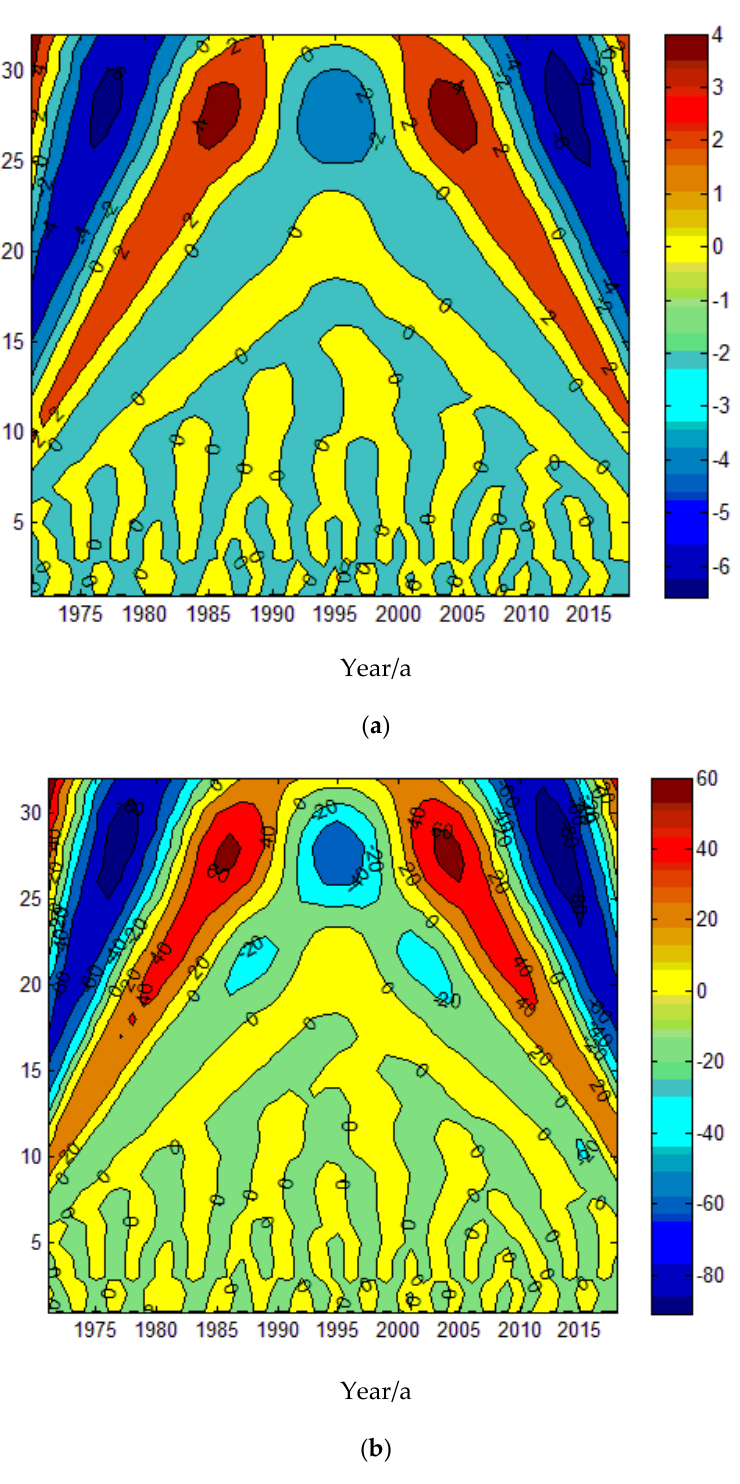
Figure 7. Contour characteristics of the real part of Morlet wavelet coefficients of annual temperature ( a ) and precipitation ( b ) in Fujian from 1971 to 2018.